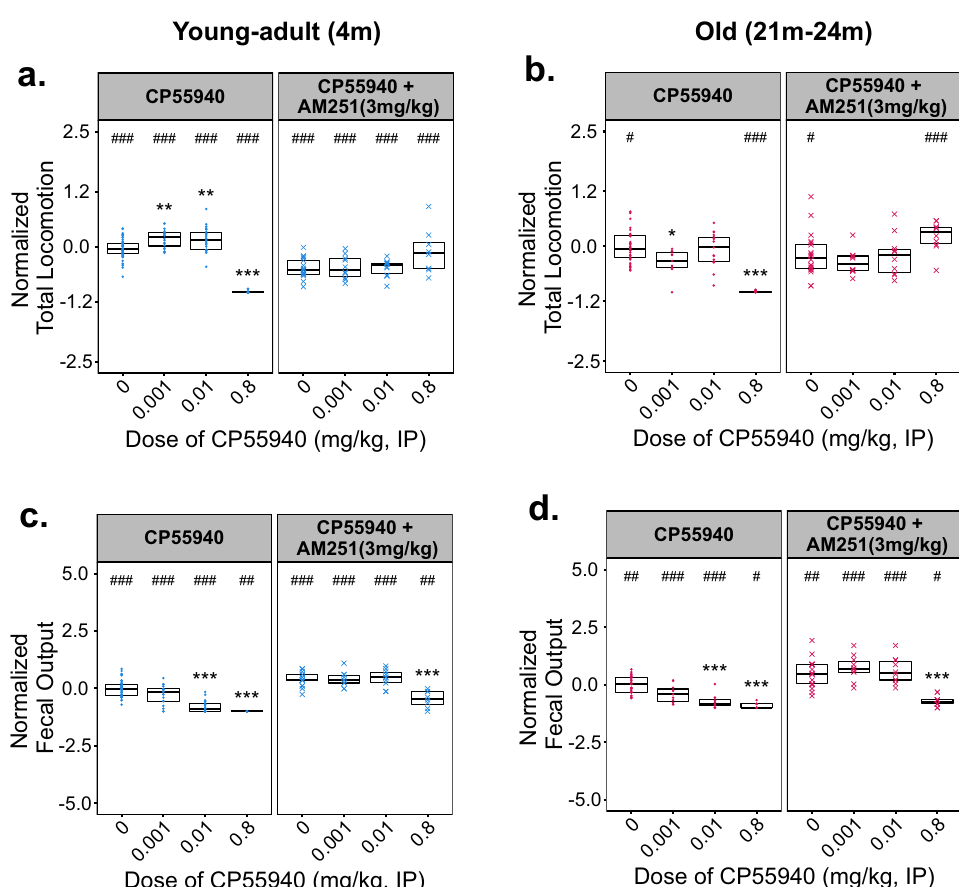
Fig. 2 Effects of CP55940 Co-administered with the CB1 inverse agonist AM251 on locomotion and fecal output in young – adult (4 m) and old (22 m) male C57BL/6 mice. Varying doses of CP55940 were administered alone or in a pre-mixed solution with 3 mg/kg of AM251 to young – adult and old male mice. a , c Total distance moved ( a ) and total fecal output ( c ) by young – adult (4 m) mice during 30 m of open- fi eld testing. b , d Total distance moved by old (22 m) mice during 30 m of open- fi eld testing. All data have been normalized to the responses of vehicle-treated age-matched control animals which were tested at the same time. Individual data points for each testing group are overlaid on Tukey-style boxplots. The lower and upper edges of each box represent the fi rst and third quartiles, respectively. The middle horizontal line in each box depicts the median of that dose/age group. Sample sizes for every treatment group and fi gure panel are listed in Supplementary Fig. 5. Signi fi cant omnibus results were followed by planned post hoc contrasts of each dose vs. vehicle-treated control groups using Dunn ’ s method. The false discovery rate was corrected for using the Benjamini, Hochberg, and Yekutieli method. Within an age group, signi fi cant differences ( P < 0.05) between a given dose and the vehicle-treated response (0 dose) are indicated using asterisks (*). Differences between CP55940 alone and CP55940 + AM251 at a given dose are indicated by pound signs